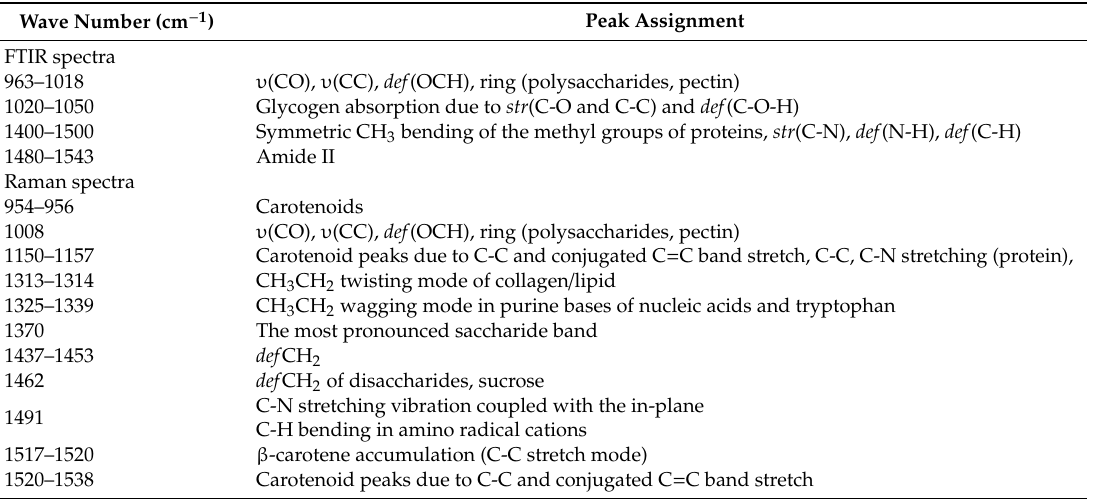
Figure 3. Averaged, intensity-normalised and background subtracted ( A ) FTIR and ( B ) Raman spectra of unfermented carrot juices and fermented carrot juices by L. gasseri strains: (i) Unfermented straight juice, (ii) Straight juice fermented by DSM 20604, (iii) Straight juice fermented by DSM 20077, (iv) Unfermented concentrated juice, (v) Concentrated juice fermented by DSM 20604, (vi) Concentrated juice fermented by DSM 20077. Abbreviations: def , deformation; str , stretching; υ , vibration. Assignments are based on studies in the references (Table 2). Table 2. Selected Fourier Transform Infrared (FTIR) and Raman frequencies and their peak assignments for the spectra shown in Figures 3 and 4